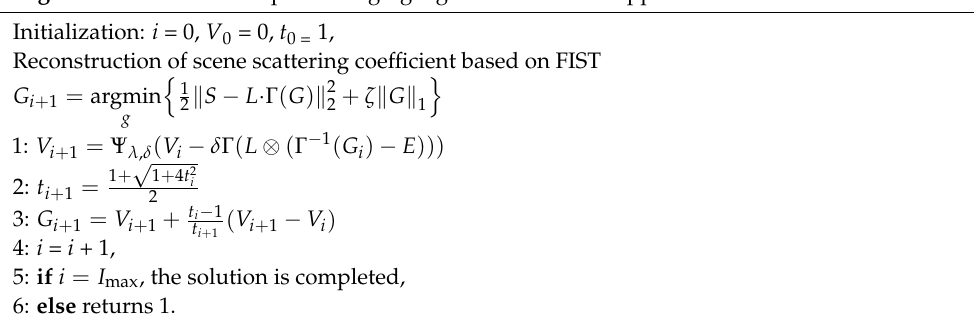
Algorithm 1 : SFCWSAR sparse imaging algorithm based on approximate